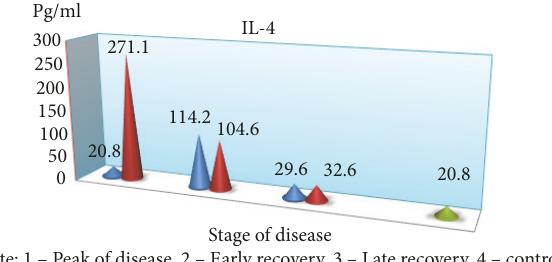
Figure 7: Dynamics of indicators of proinflammatory cytokines antagonists (IL-4) in children with